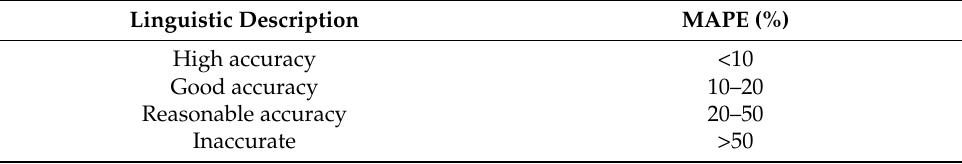
Table 1. Linguistic description of model accuracy